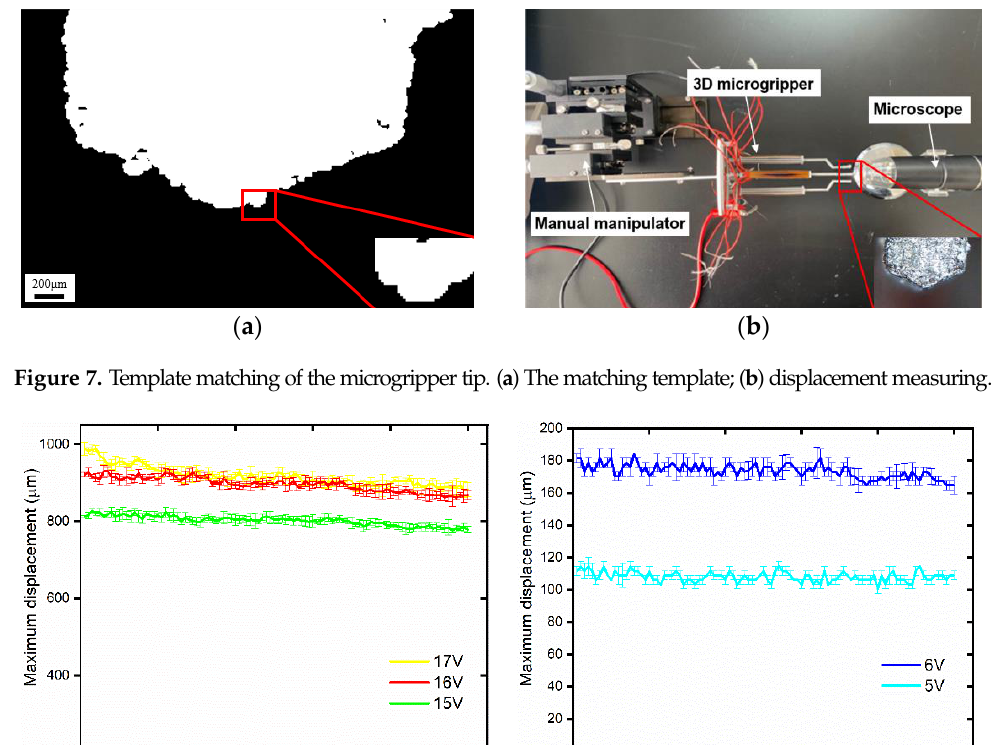
( b ) Figure 7. Template matching of the microgripper tip. ( a ) The matching template; ( b ) displacement measuring. 3.2. Durability Testing of the Polyimide Electrothermal Film Durability of the polyimide electrothermal film is of great importance to the life of the 3D microgripper. In order to test the durability of the electrothermal film, a set of voltages are applied to the polyimide film. First, a voltage is applied to the polyimide film for one minute to heat the polyimide film sufficiently. After cooling down for one minute, another cycle of application of voltage is performed. The sizes of the polyimide films for